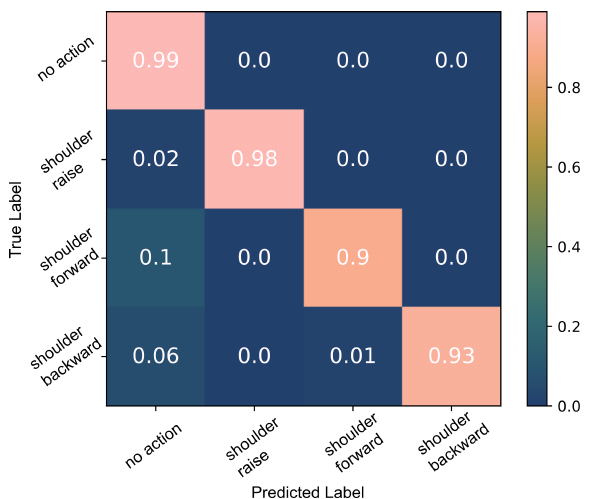
Figure 10. Classification of the three shoulder movements: the 10-fold cross-validation results of the decision tree algorithm which was trained using SR , SF and SB data.